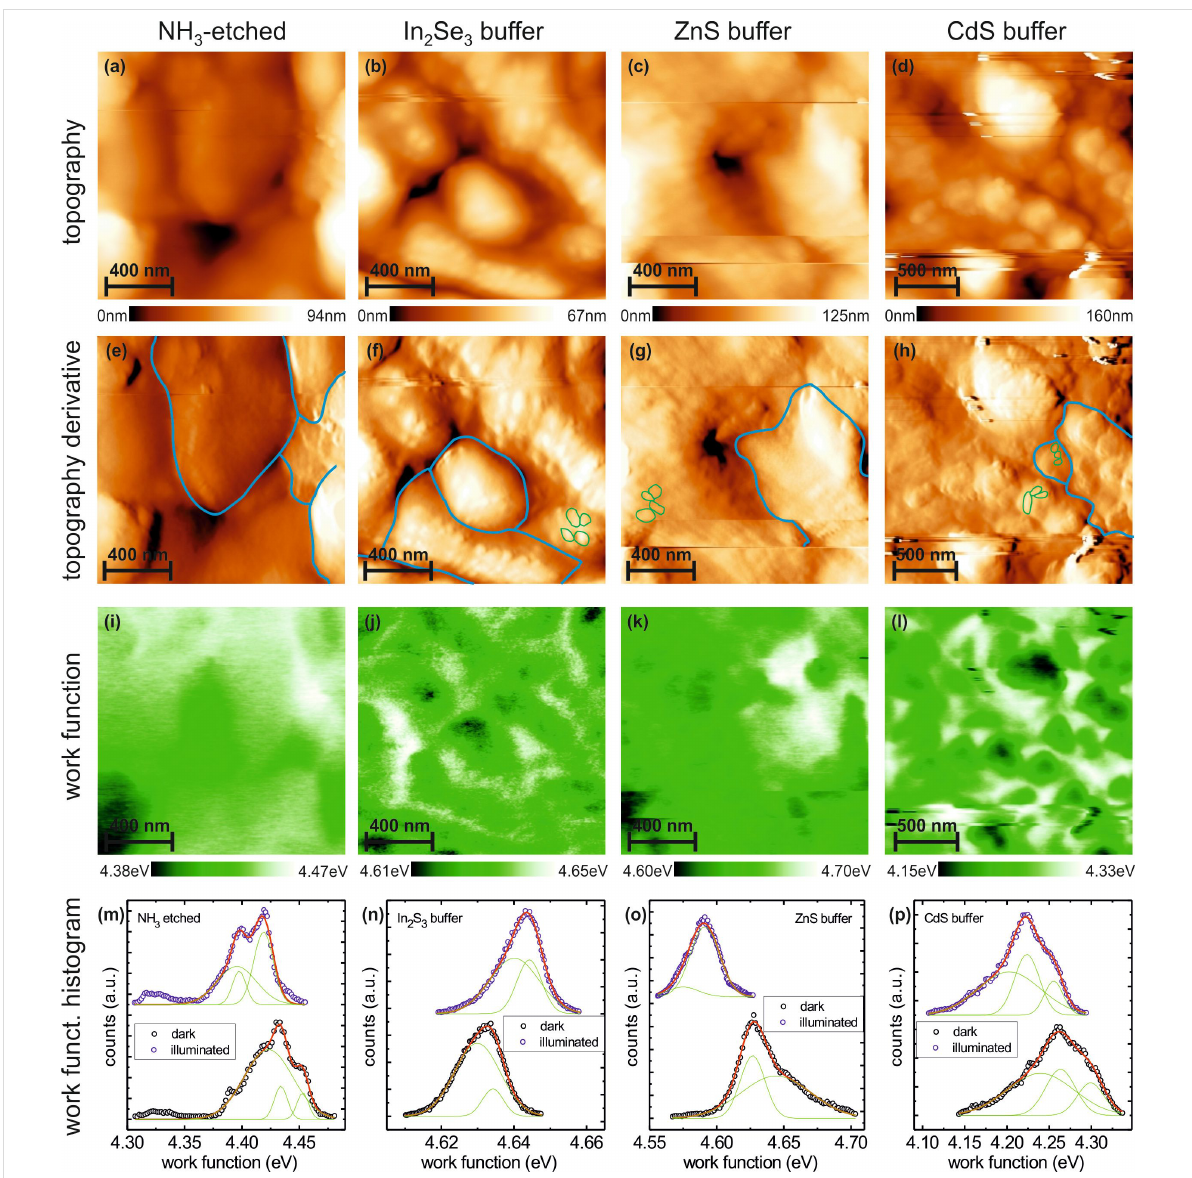
Figure 2: KPFM measurements of the (from left to right) NH 3 -etched Cu 3 BiS 3 , and Cu 3 BiS 3 with the In 2 S 3 , ZnS and CdS buffer layers. The rows show, from top to bottom, the topography image, the derivative image of the topography, and the simultaneously recorded work-function image in the dark. The bottom row shows histograms of the work-function images in the dark (lower curve) and under illumination (upper curve) with respective Gaussian fits to describe the work function